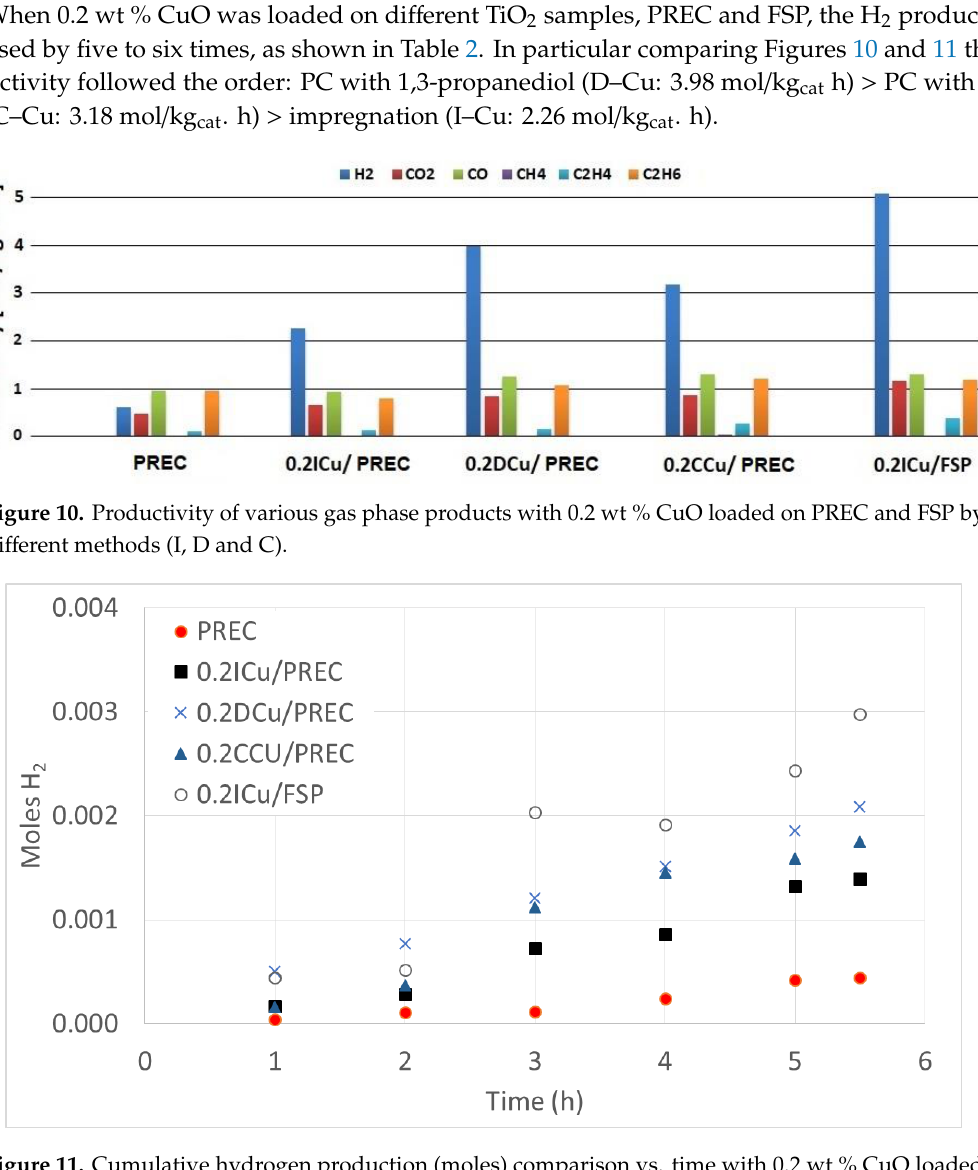
Figure 9. Attenuated Total Reflectance Fourier-Transform Infrared Spectroscopy (ATR-FT-IR) spectra of ( a ) P25 powder before reaction, ( b ) P25 analyzed after the PR reaction.